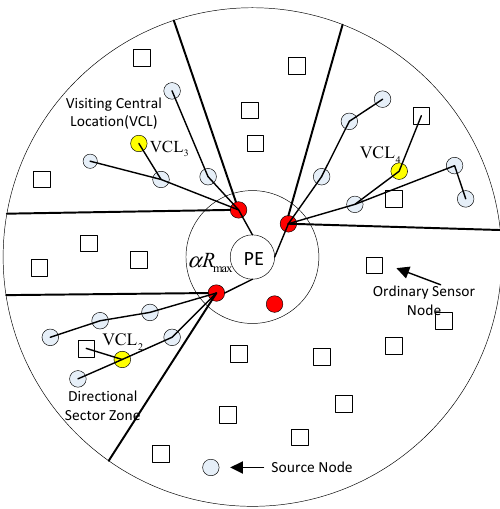
Figure 10. Explanation of Directional Source Grouping Algorithms.